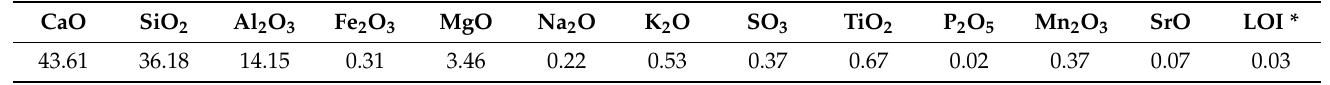
Table 1. Chemical composition of blast furnace slag